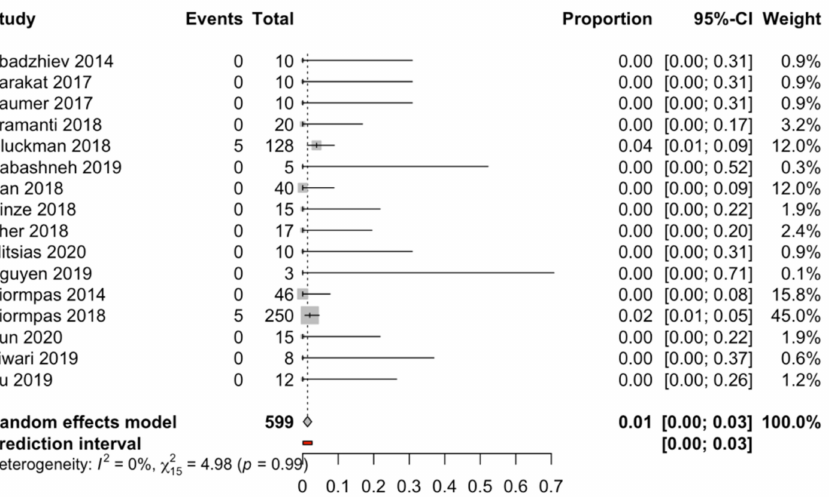
Figure 2. Forest plot of the meta-analysis of implant failure with immediate dental implant placement using the socket-shield technique.